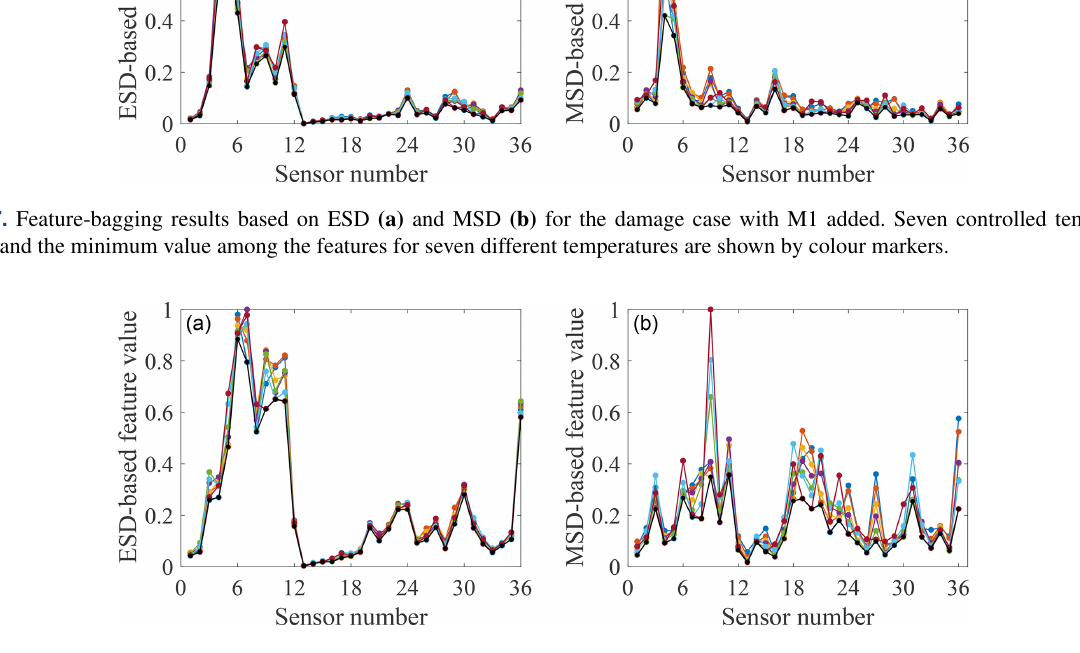
Figure 8. Feature-bagging results based on ESD (a) and MSD (b) for the damage case with M2